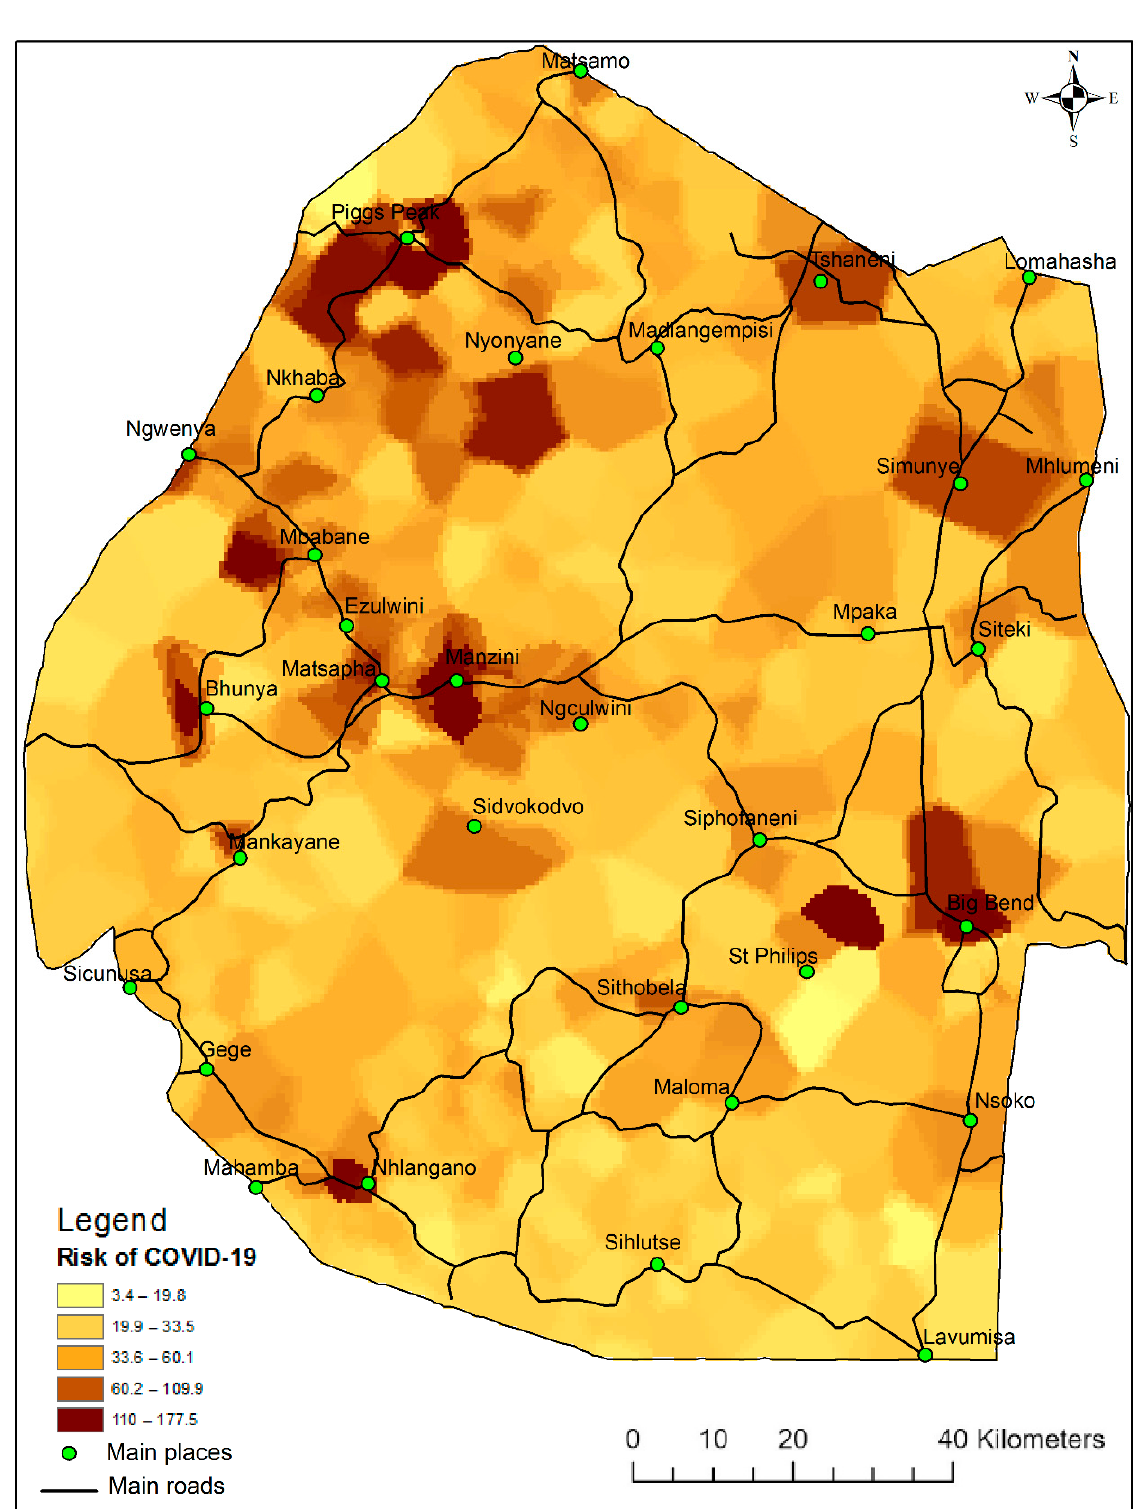
Figure 3. Predicted risk of COVID-19 infections in Eswatini.